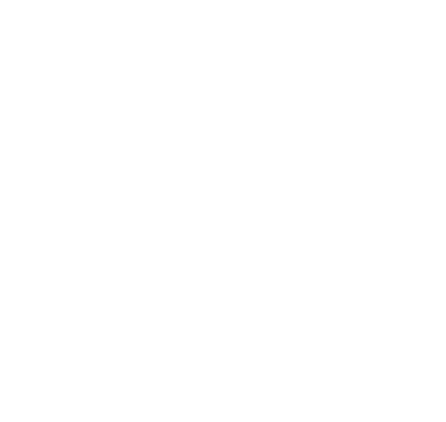
Table 4. Skin friction